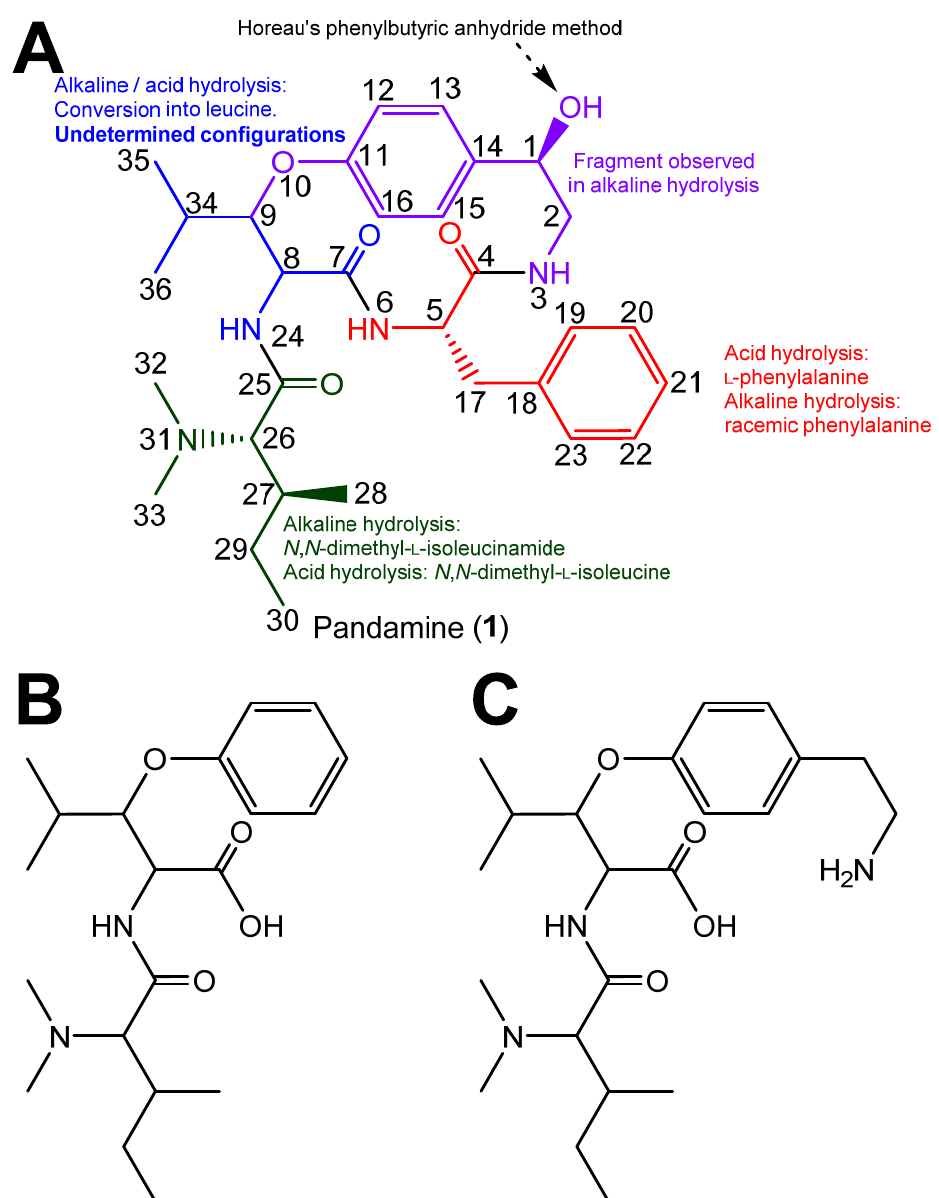
Figure 1. ( A ). Chemical structure of pandamine as determined by Goutarel, and supportive analytical evidence for highlighted fragments. ( B , C ). Key acid hydrolysis fragments observed from pandamine ( B ) and 1-deoxypandamine ( C ).